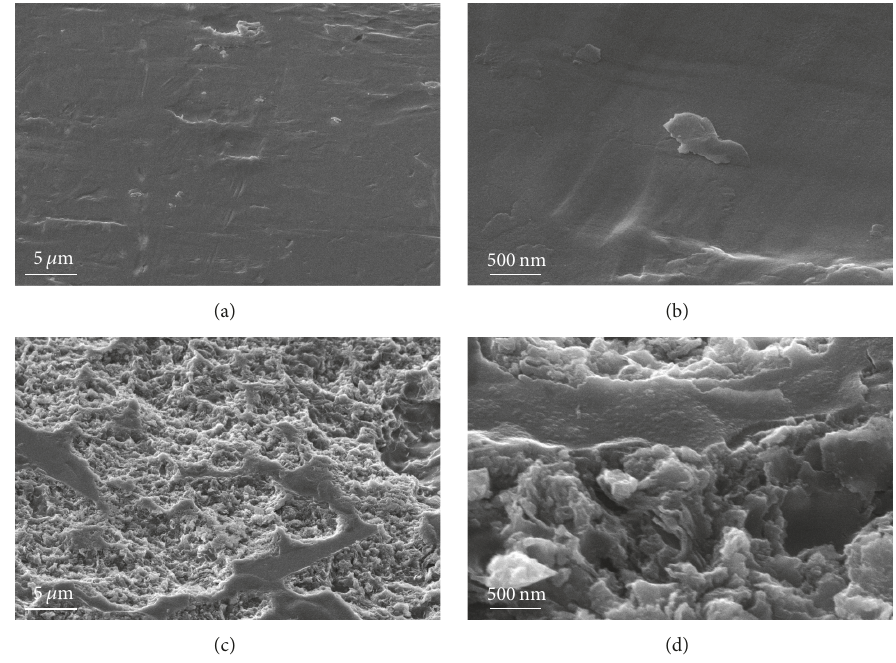
Figure 1: Surface topography of the (a-b) Ep and (c-d) Ep+An implant surfaces.